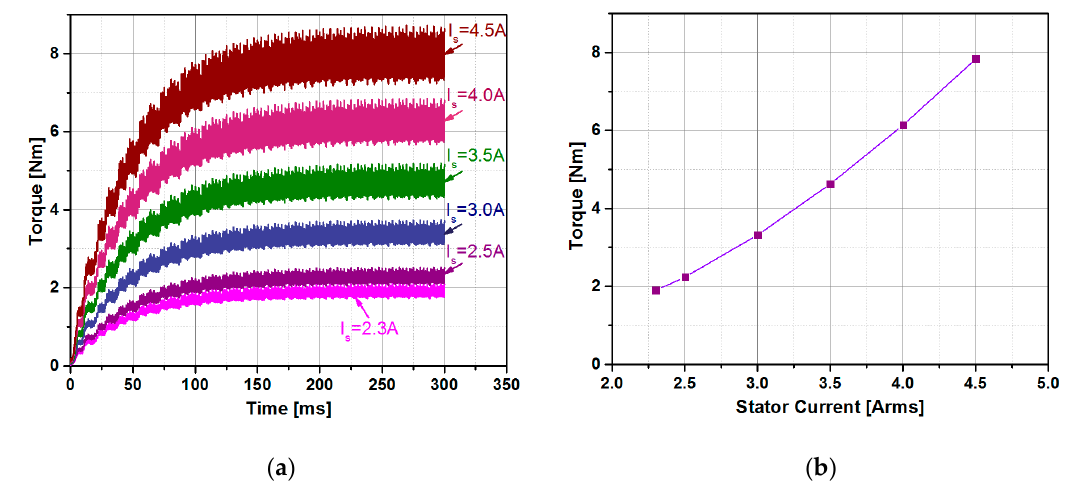
Figure 16. Variation of torque with stator current: ( a ) waveform; and ( b ) average values.